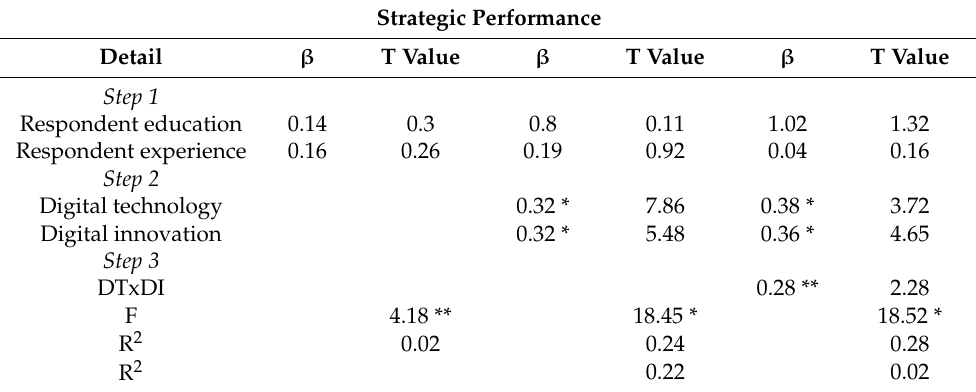
Table 6. Hierarchal regression results for the moderating effect of digital